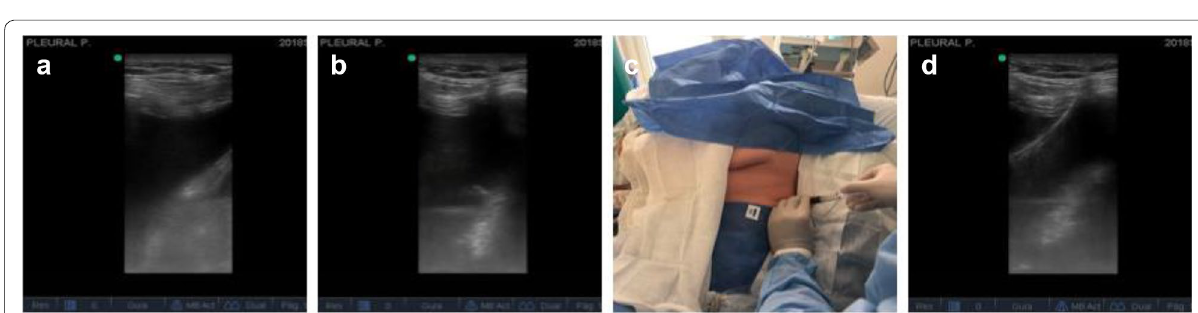
Fig. 2 a Assessment, with a 13-MHz linear transducer, of the effusion in the lower aspect of the thorax on the posterior axillary line, visualizing the upper and lower ribs, intercostal space, pleural fluid, and diaphragm. b After verifying no interposition of vessels with color Doppler, needle puncture is performed; needle passage into the pleural cavity is visualized in real time. c Pleural fluid return is verified, in this case blood. d Passage of the guide toward the pleural cavity on the diaphragm